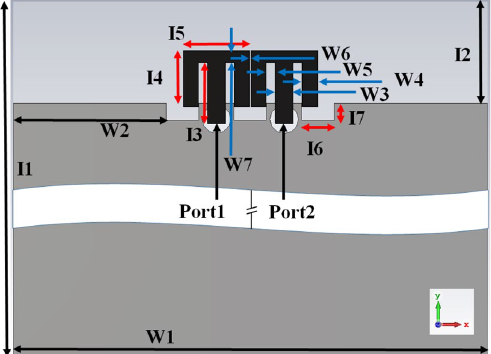
Figure 1. Optimized design of closely-couple 2-Member MIMO (M-shaped) antenna